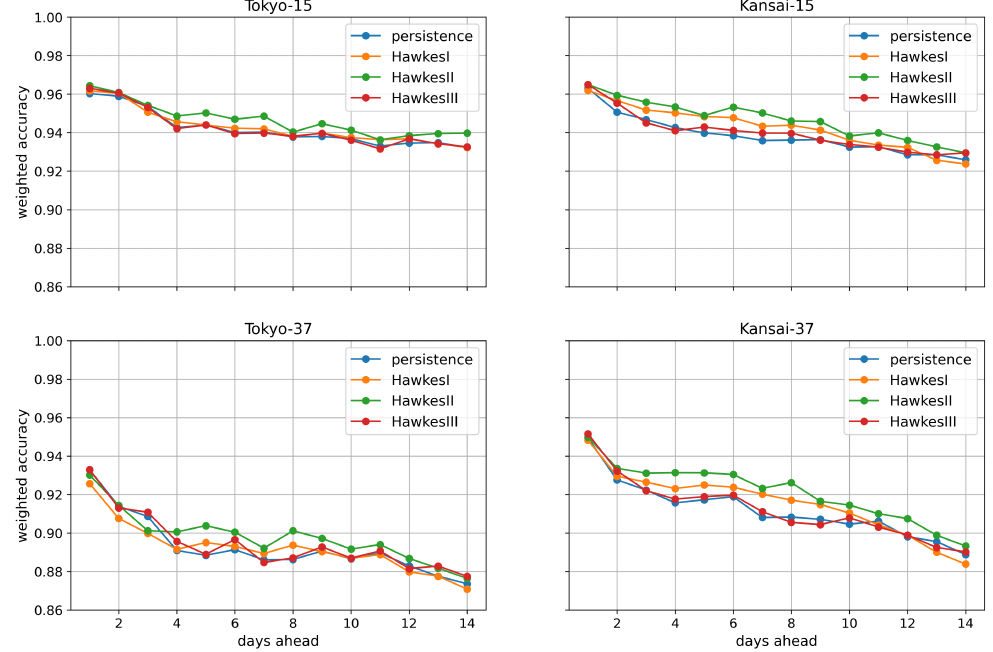
Figure 9. Variation of weighted accuracy WACC with forecasting horizon for the selected areas and trading time periods.